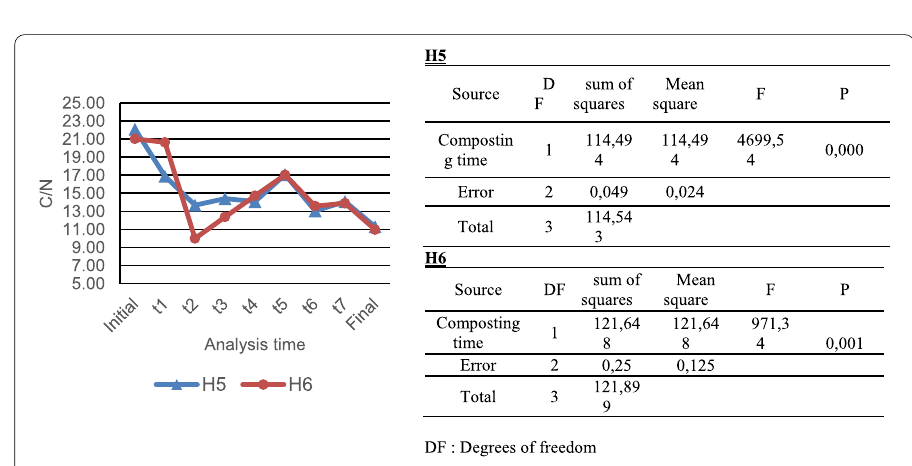
Fig. 8 C/N evolution during co‑composting of TM and OP (left) and ANOVA test associated (right)